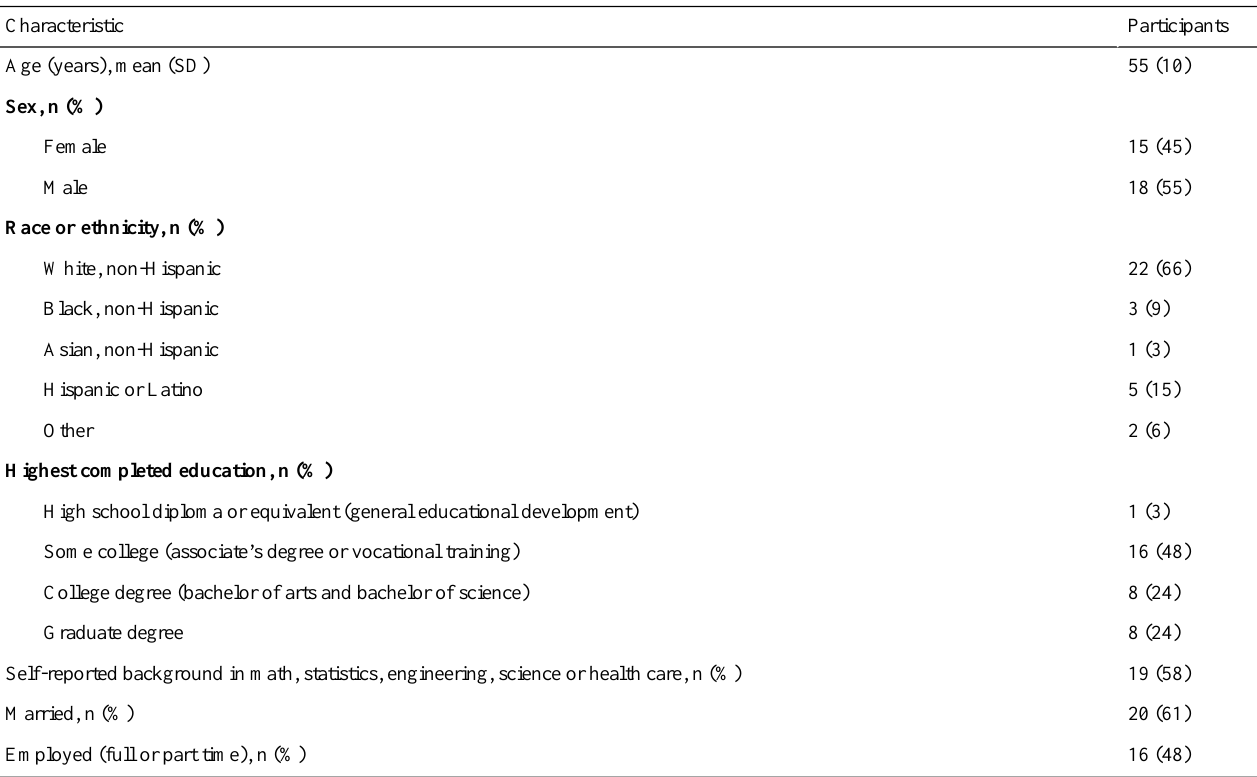
Table 1. Sociodemographic characteristics of Personalized Research for Monitoring Pain Treatment participants who participated in qualitative interviews